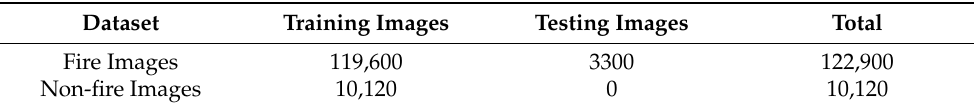
Table 2. Distribution of fire and non-fire images in the